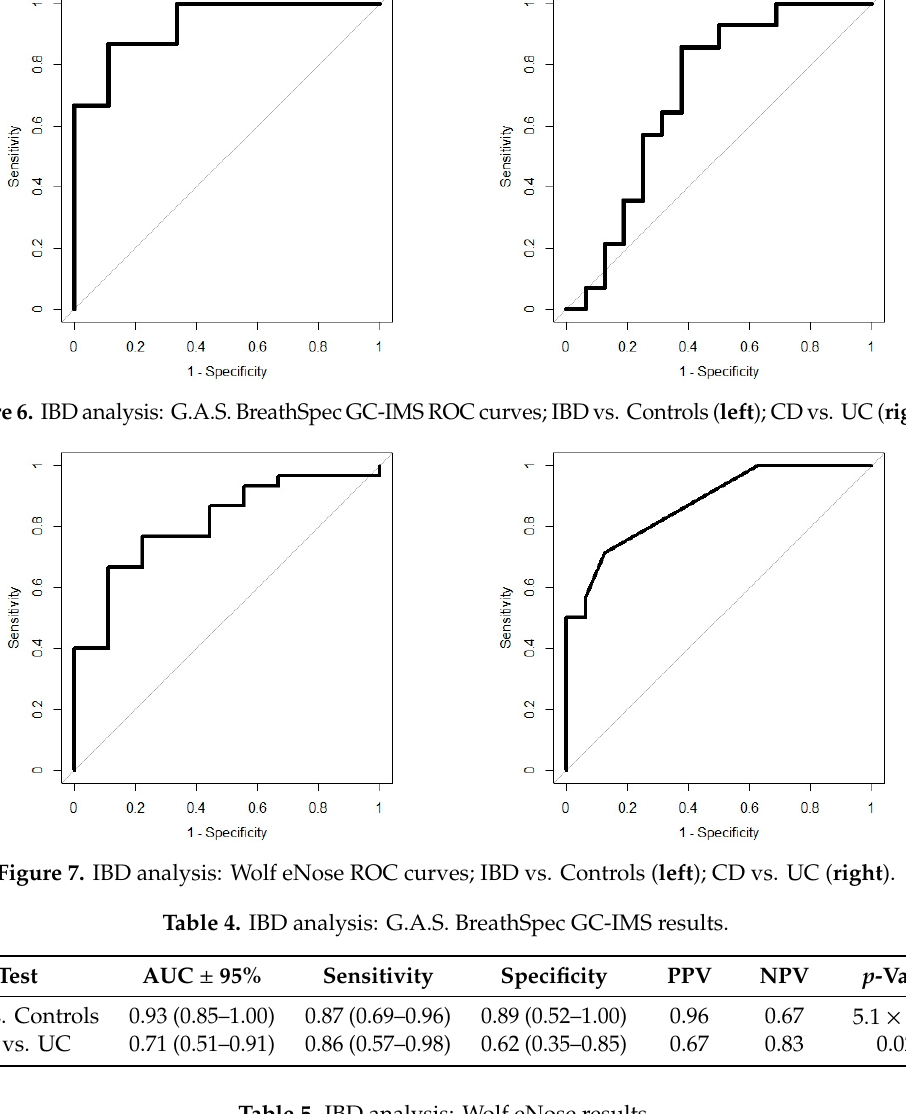
Table 5. IBD analysis: Wolf eNose results.